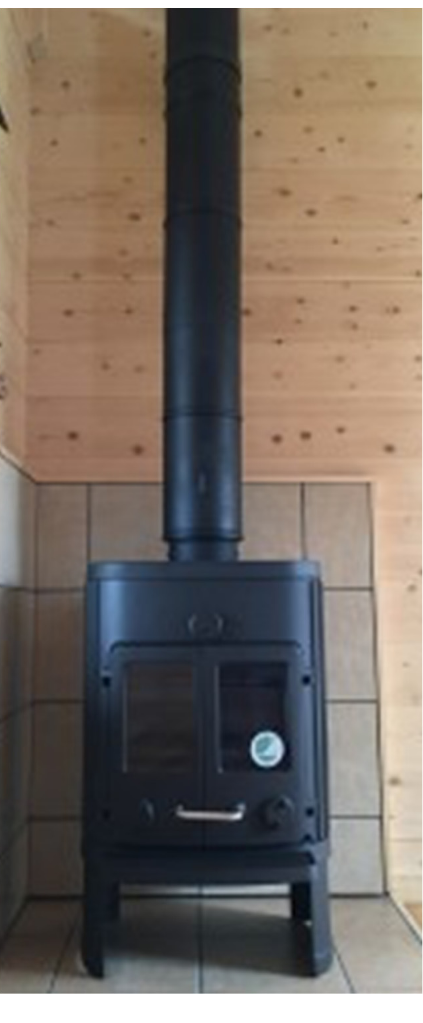
Figure 1. A wood stove and chimney ( left panel ) used in this study and fires in the stove oven ( right panel ).